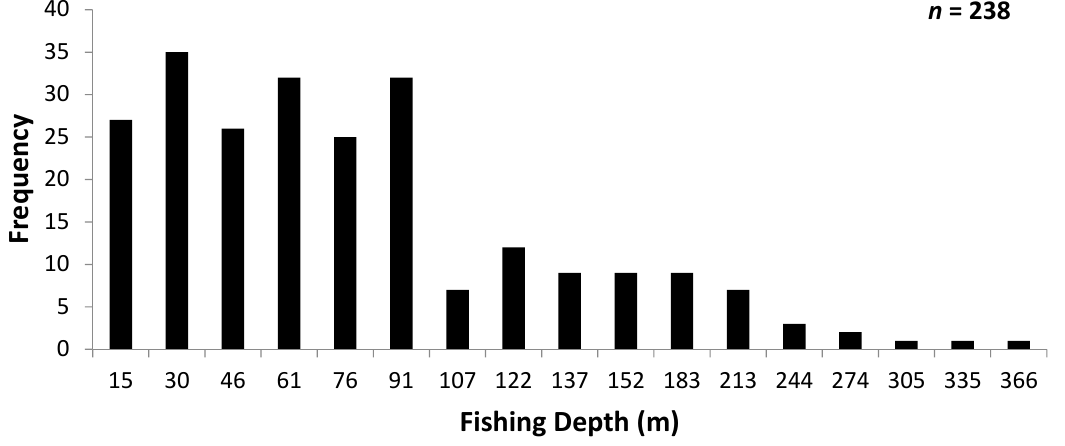
Figure 4. General nighttime fishing depth targeted by recreational anglers pursuing swordfish off Southeast Florida.